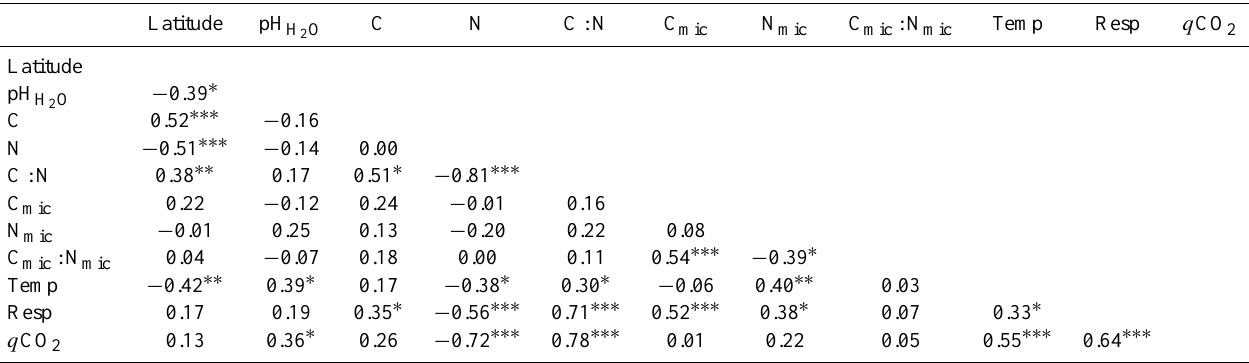
Table 2. Pearson’s correlation coefficient of the latitude of the study site, the pH H of the soil litter layer, the C and N concentration and 2 O the C:N ratio of the soil litter layer, the microbial biomass C and N concentration (C mic and N mic ), the microbial biomass C:N ratio, the incubation temperature at which the respiration rate was determined (Temp), the respiration rate (Resp), and the metabolic quotient ( q CO 2 ). Latitude pH H 2